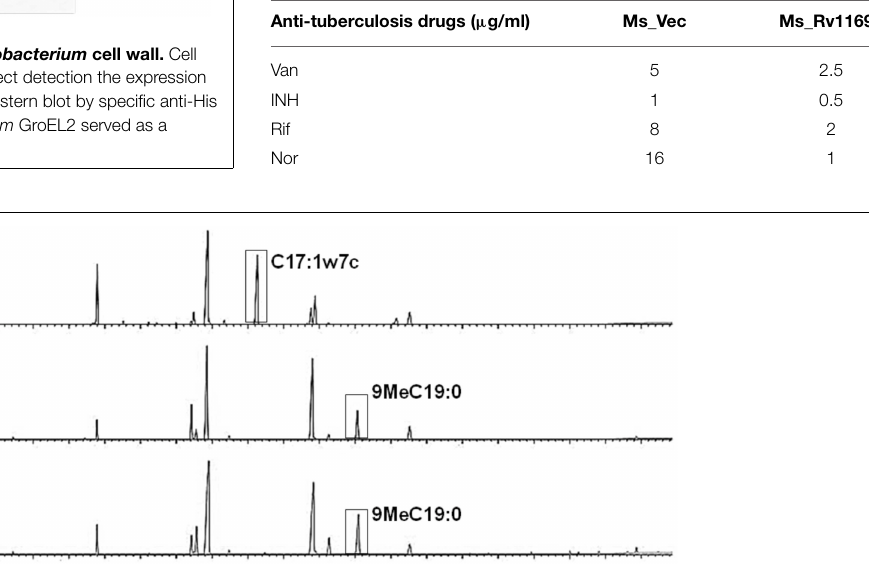
Frontiers in Microbiology |